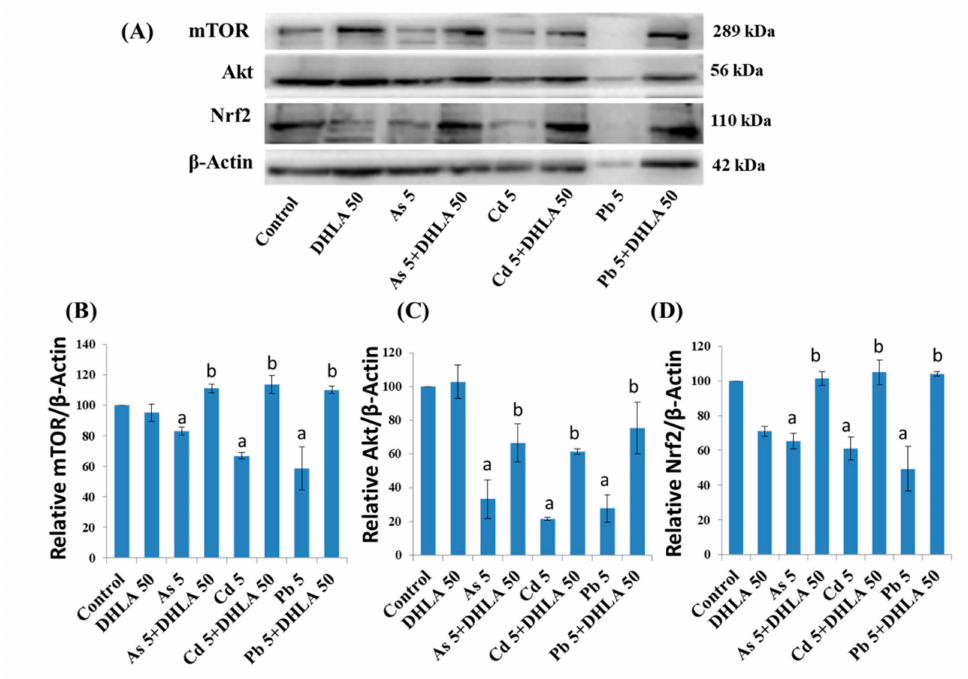
Figure 11. ( A ) Western blot analysis of protein expressions, and quantification of ( B ) mTOR, ( C ) Akt and ( D ) Nrf2 in the PC12 cells after treatment with metals with DHLA for 48 h. The values of the bars indicate the mean ± SEM ( n = 3). Here, “a” denotes a significant difference compared to the control group ( p < 0.05), and “b” denotes a significant difference compared to the associated metal group ( p <